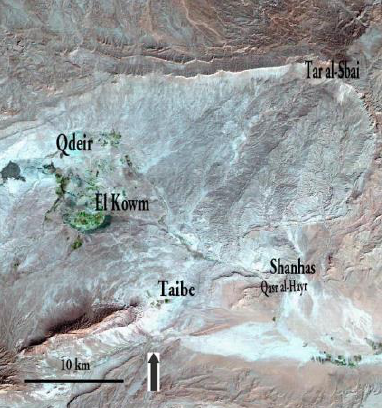
Figure 8. The oasis of El/Al Kowm on the western piedmont of Jebel Bishri and Tar al-Sbai, a semi-circular escarpment of the mountain visible in Landsat-7 ETM. ©EurImage. Mapping by M. Lönnqvist (present Silver) 2009.